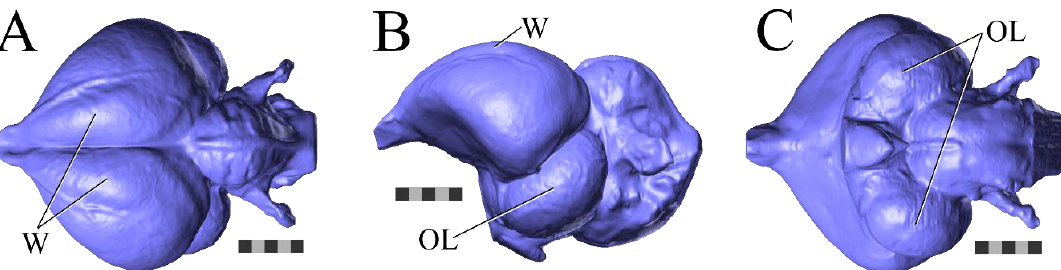
Figure 1. The endocast of an extant bird, Bonasa umbellus (AMNH Birds SKEL 21616), in ( A ) dorsal, ( B ) lateral, and ( C ) ventral views showing the location of the Wulst and optic lobe on an avian endocast. For all views, rostral is to the left. Abbreviations: OL, optic lobe; W, Wulst. Scale bars = 5 mm.